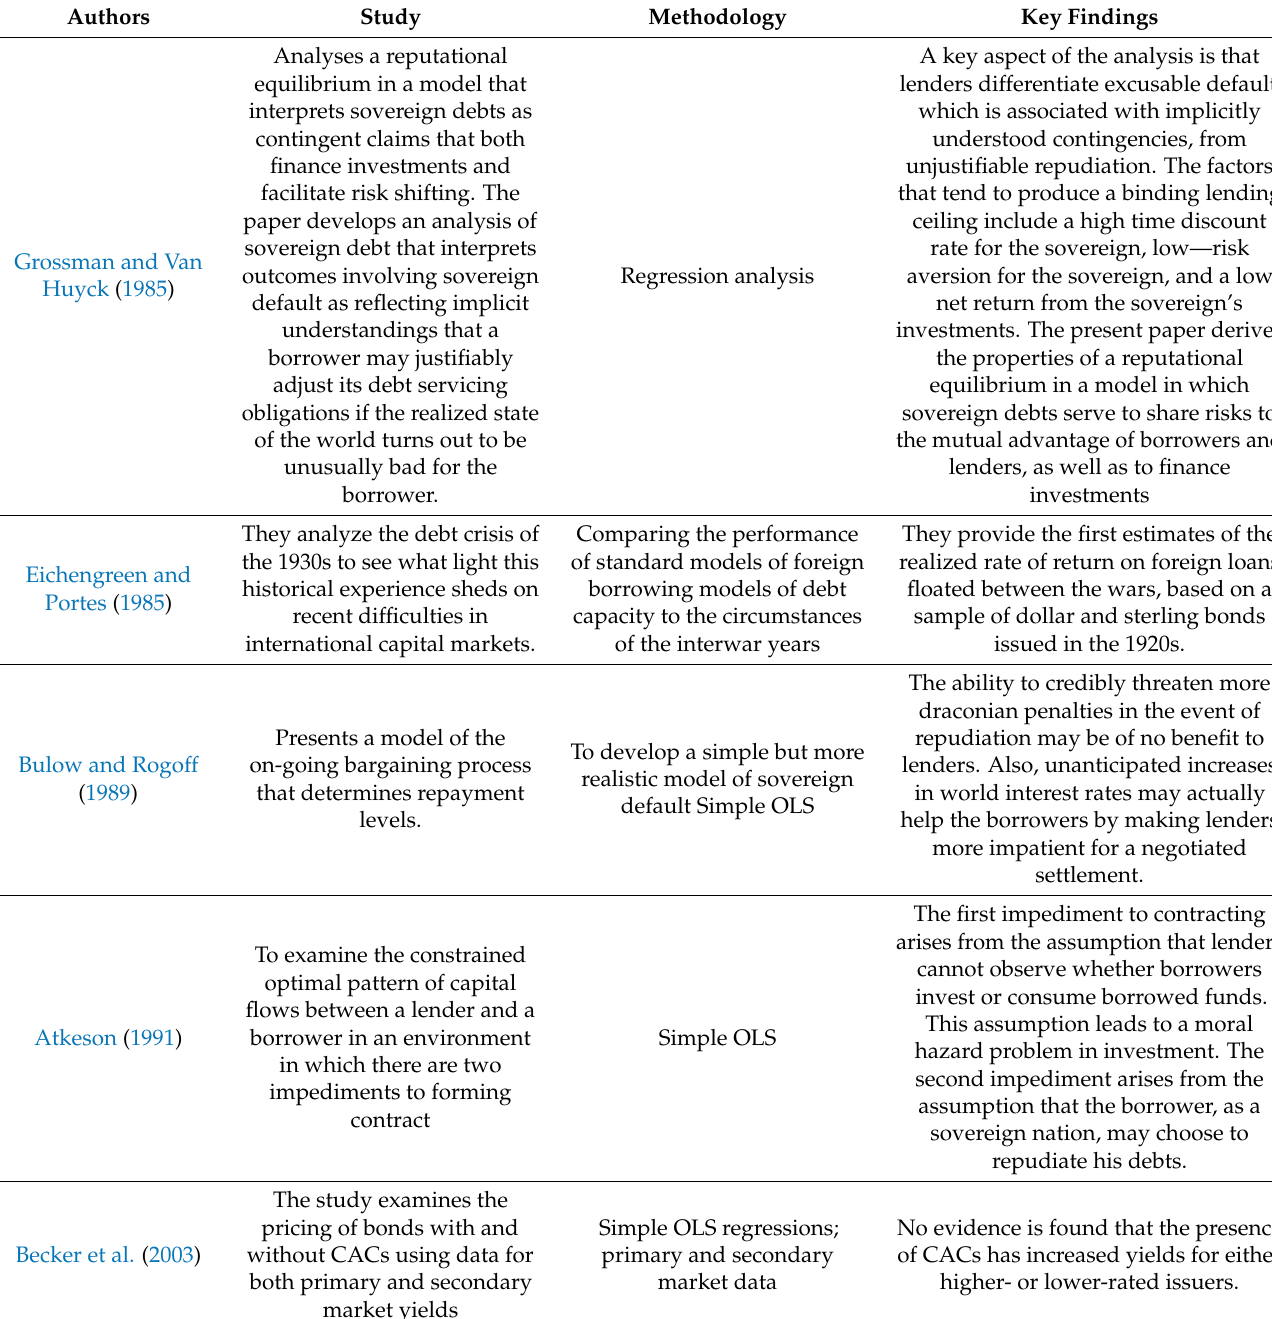
Table A1. Synopsis studies on CACs, sovereign debt, and sovereign yield spreads (Source: